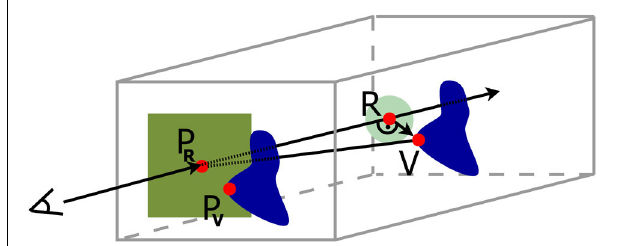
FIGURE 5 | Schematic illustration of the construction from the closest depth point of the volume of interest V onto the view ray R . In dark blue we see in the back the volume of interest and its projected depth texture on the near clipping plane. The dark green area limits our search area from the ray entry point P R to a nearby VOI point P V , and the light green circle with radius r 2 limits the top surface size.